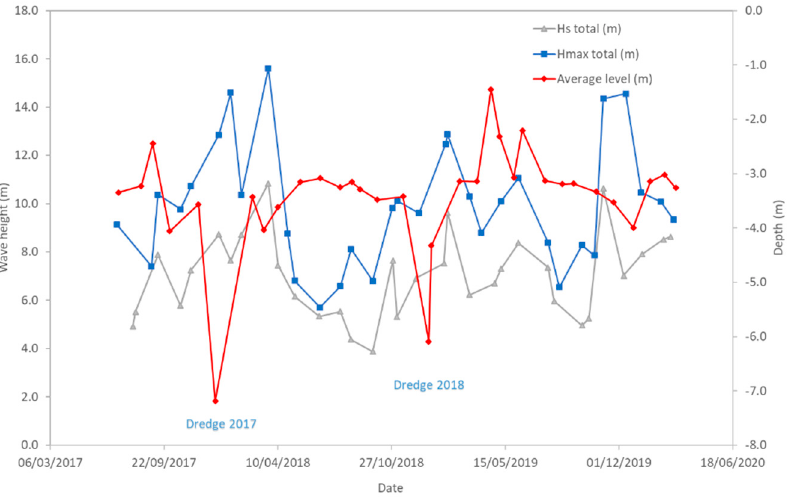
Figure 9. The effect of the wave height (H) on the average level of the dock in the Port of